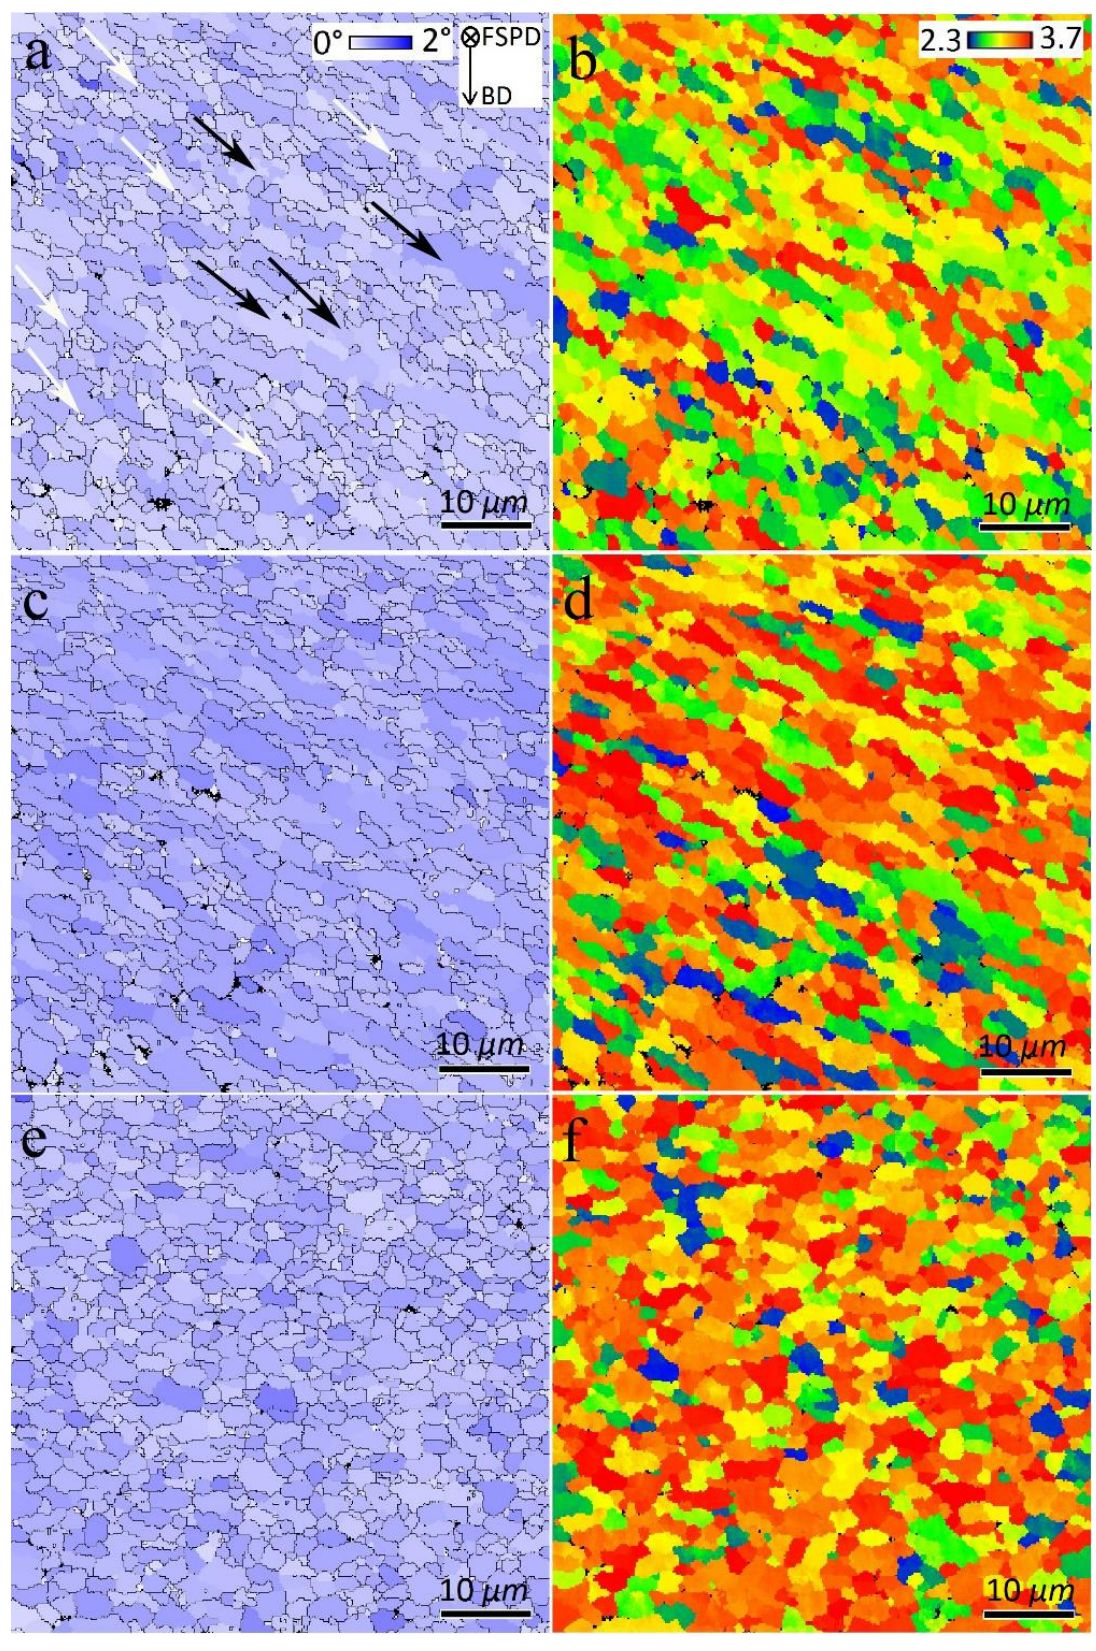
Figure 8. Grain average misorientation (GAM) and Taylor factor maps of SZs: ( a , b ) S1, ( c , d ) S2, and ( e , f ) S3.